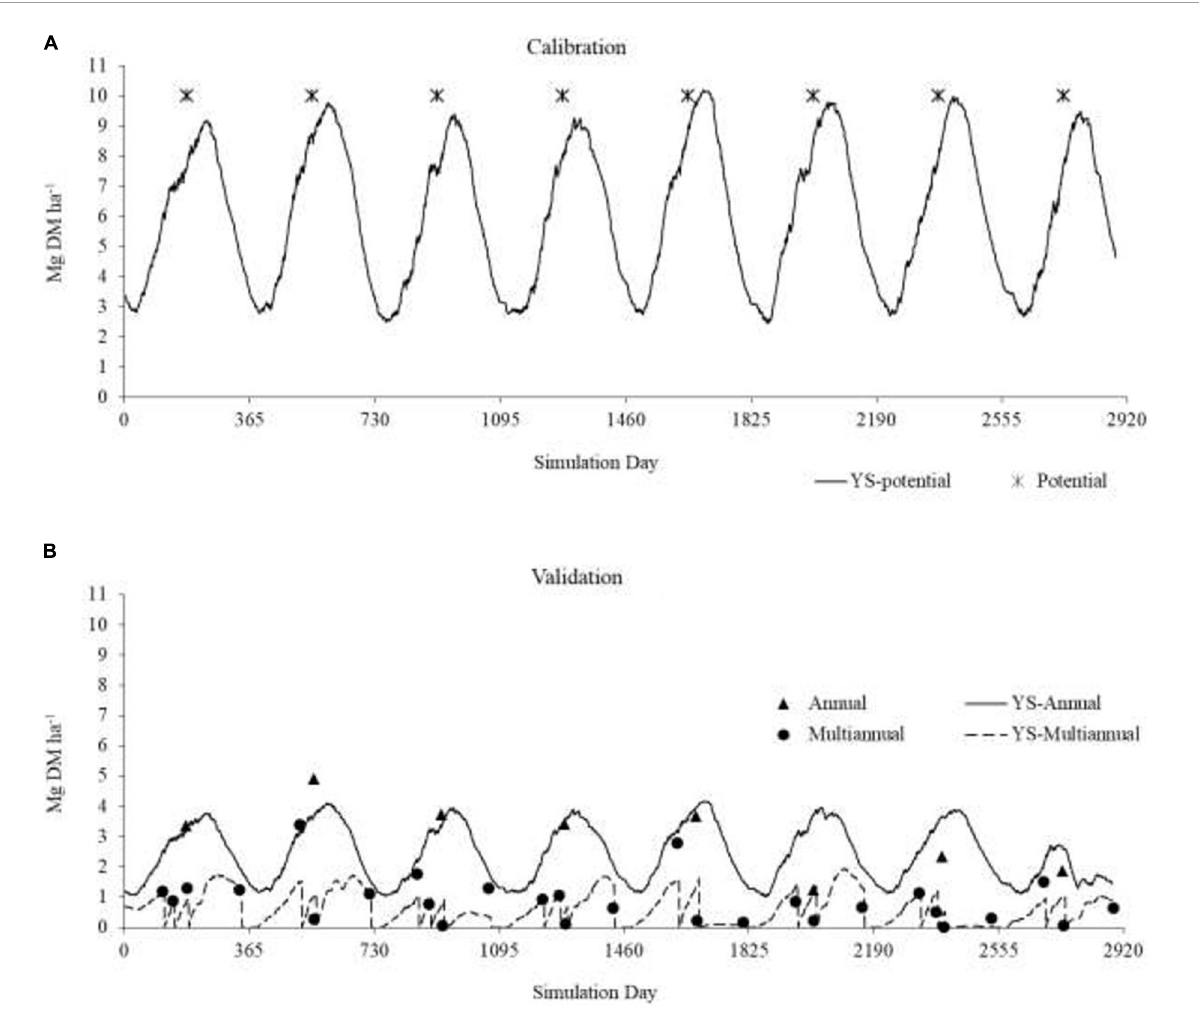
FIGURE2 Results of the calibration (A) and validation (B) of the Yield-SAFE (YS) model for the pasture production ( Dactylis glomerata ) [Mg dry matter (DM) ha - 1 ] in Galicia (NW